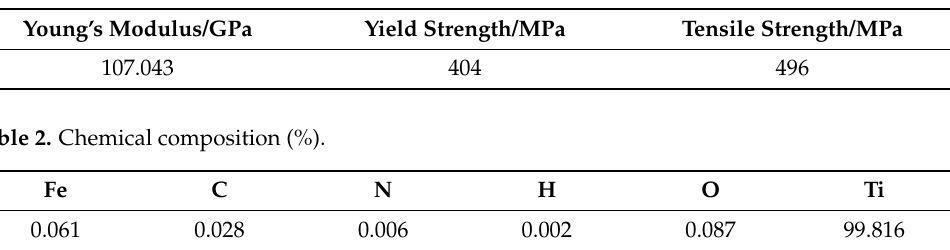
Table 1. Mechanical properties.